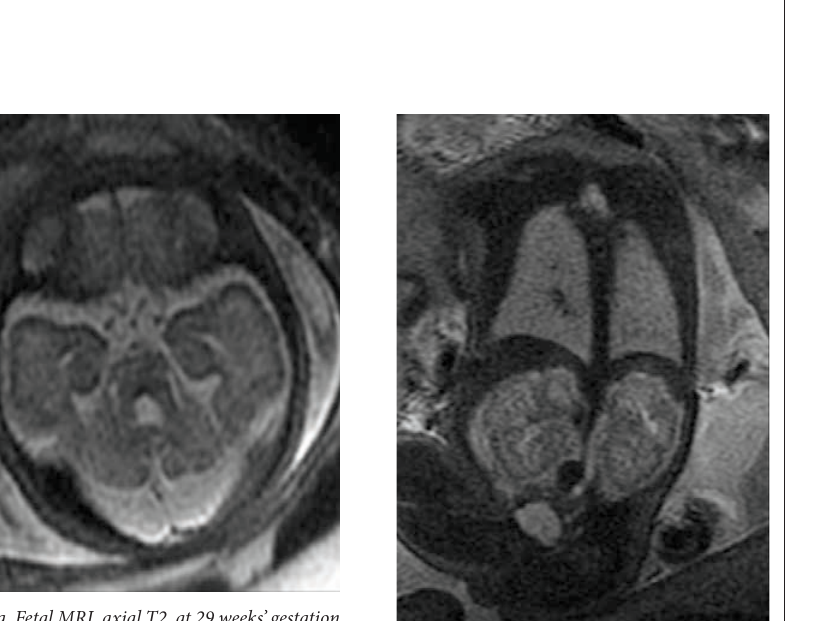
Fig. 2. Joubert syndrome demonstrating the molar tooth sign on axial T2 MRI in a 10-year- old boy with chronic liver disease being treated for Wilson disease with chelation therapy. In view of oculomotor apraxia and presence of the molar tooth sign on his brain MRI, JSRD was diagnosed. Genetic evaluation revealed two mutations for Joubert syndrome and, based on the presence of liver disease, diagnosis of the hepatic variant of JSRD was made.